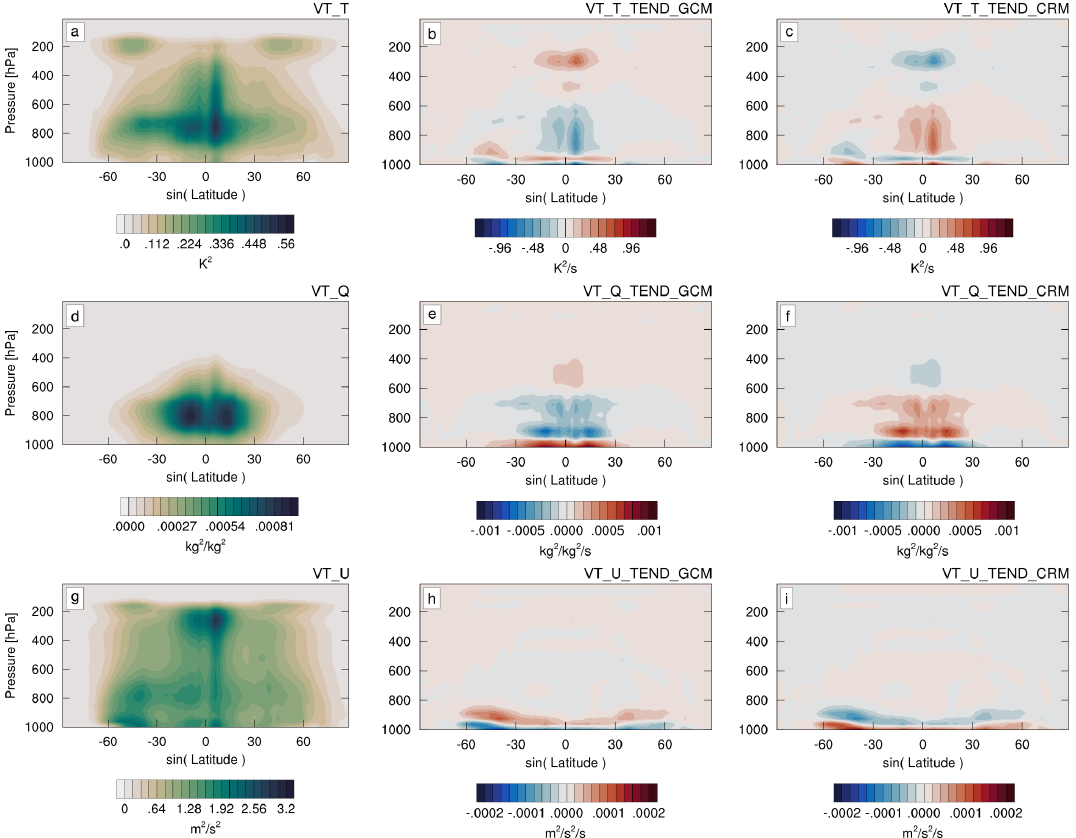
Figure 7. 10-year zonal and time-averaged CRM variance transport tracer amount (a, d, g) , GCM to CRM forcing tendency (b, e, h) , and CRM to GCM feedback tendency (c, f, i) for the E3SM-MMF+BVT case. These variance amounts and tendency values correspond to the variance transport of liquid–ice static energy (a, b, c) , total non-precipitating water (d, e, f) , and horizontal momentum (g, h, i) .